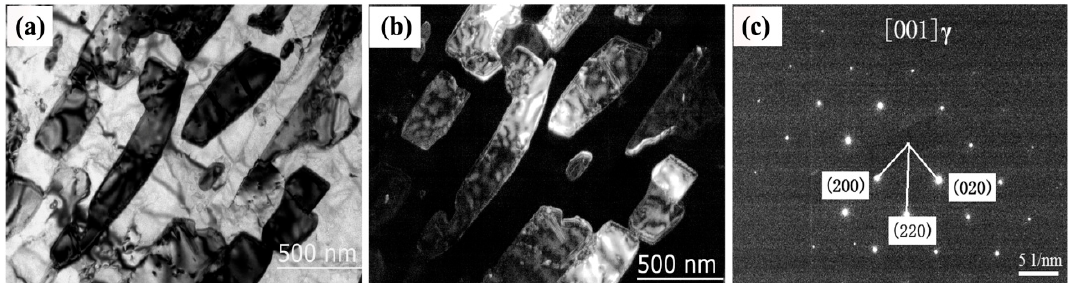
Figure 3. TEM micrographs of reverted austenite in the sample tempered at 620 ◦ C for 32 h, ( a ) bright field image; ( b ) dark field image and ( c ) SAED pattern of the reverted